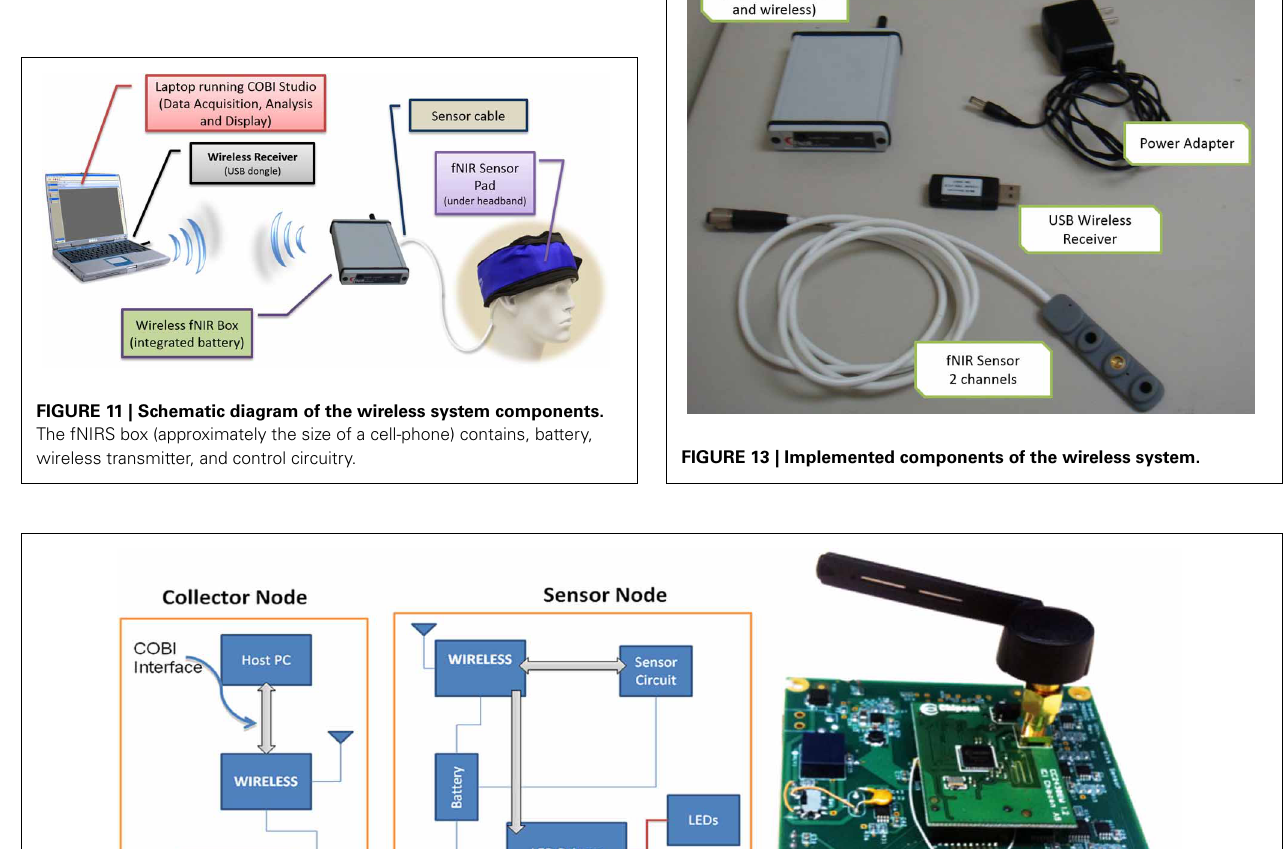
Frontiers in Human